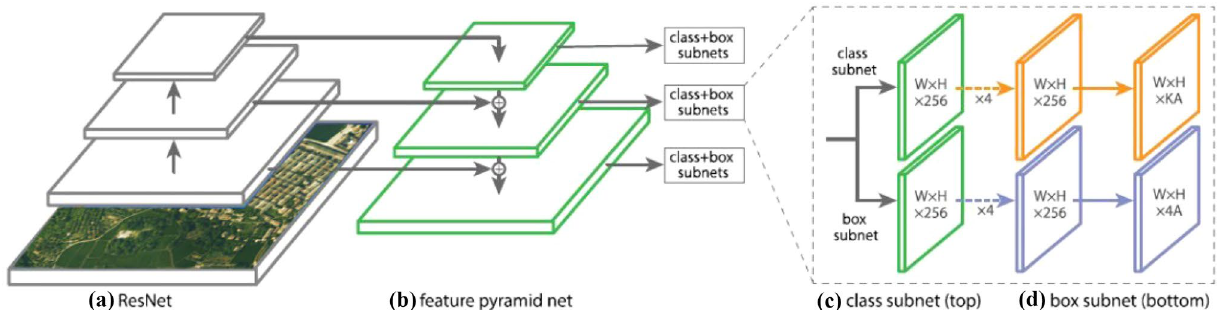
Two sub-networks are attached to this backbone, one classifies the objects in the box ( c ), and one regressing to the more accurate position of the object from the box ( d )